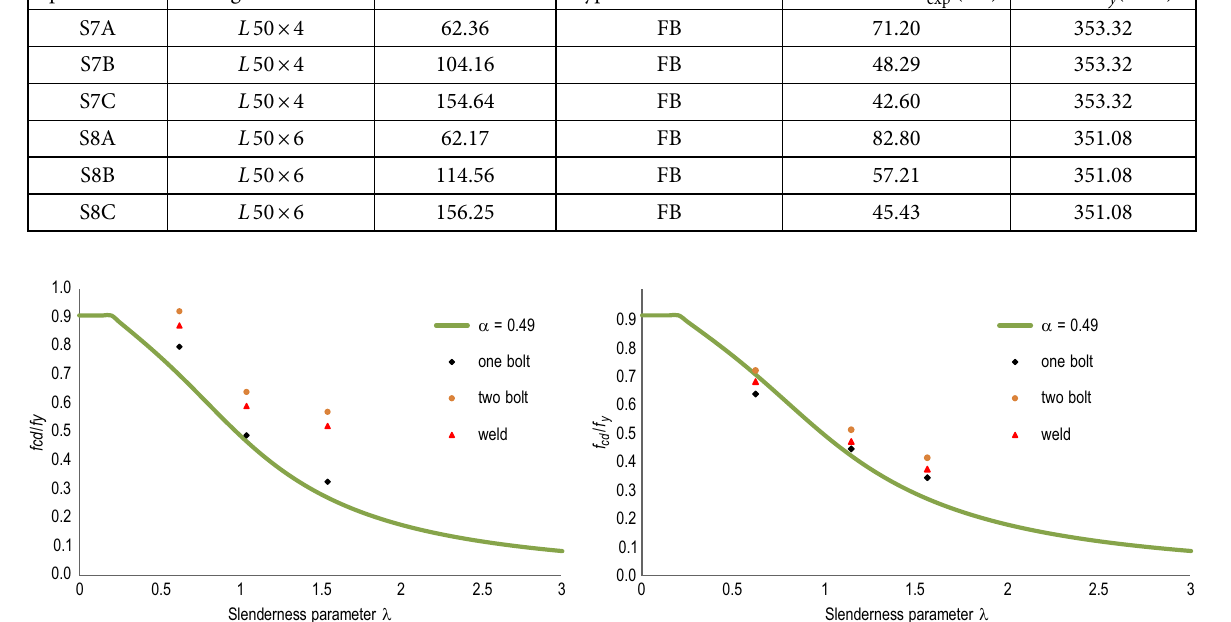
Fig. 15. Comparisons of test result for L 50 ×